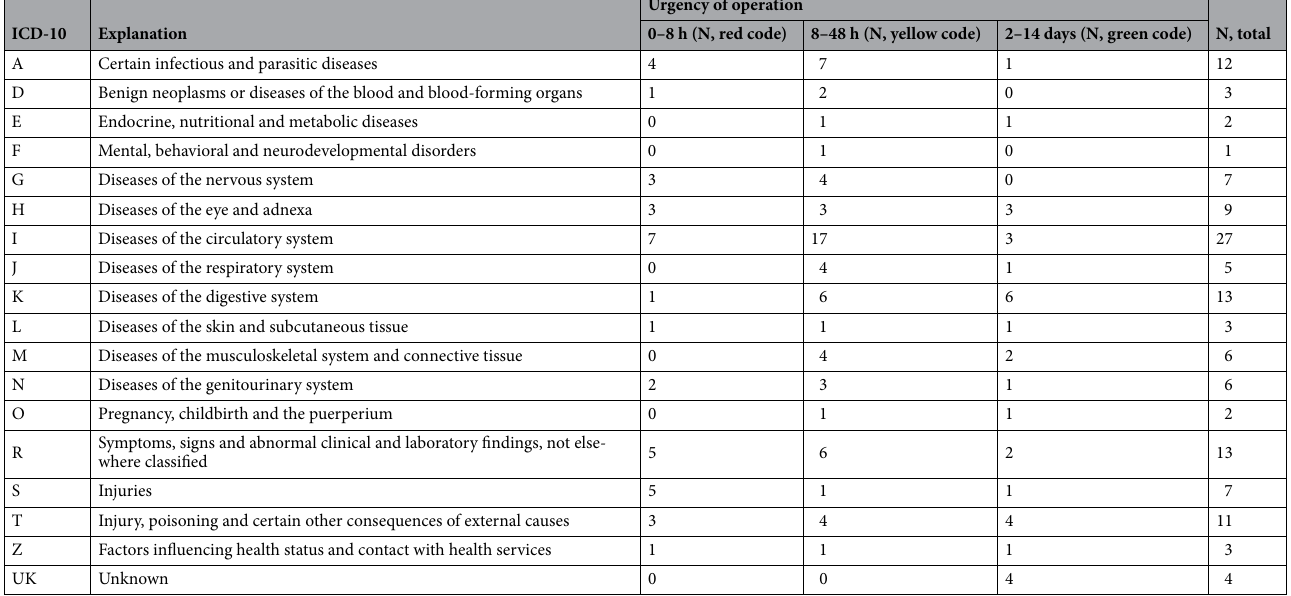
Table 2. Causes of readmission within 30 days.